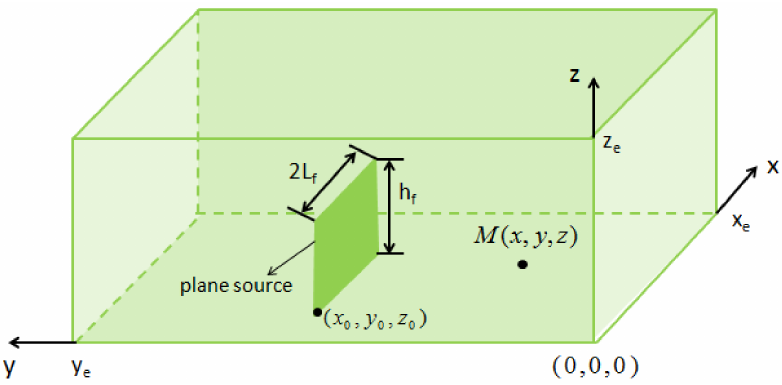
Figure A1. Schematic of a plane source in a rectilinear reservoir with no-flow outer